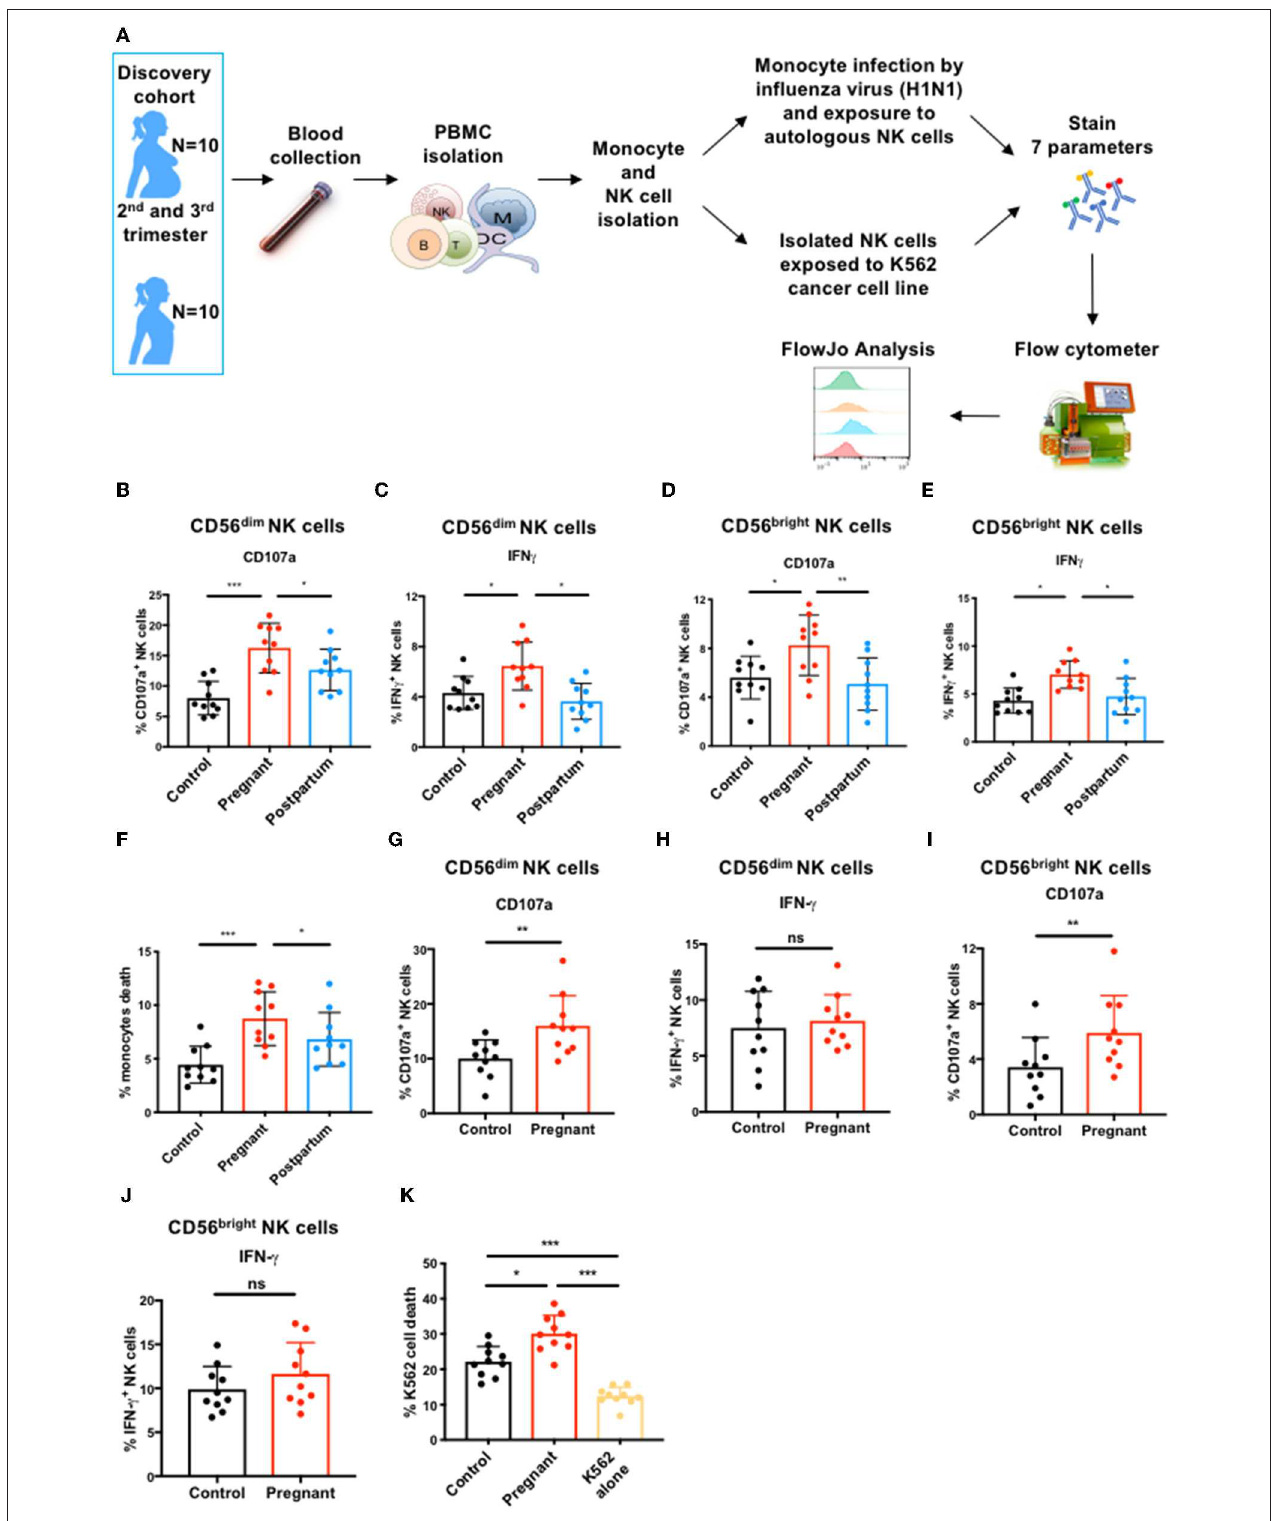
FIGURE 1 | CD56 dim and CD56 bright NK cell immune response to influenza infected and tumor cells during pregnancy. (A) PBMCs from controls ( N = 10), pregnant women ( N = 10), and post-partum women ( N = 10) in discovery cohort were isolated from blood samples. Monocytes and total NK cells were sorted and